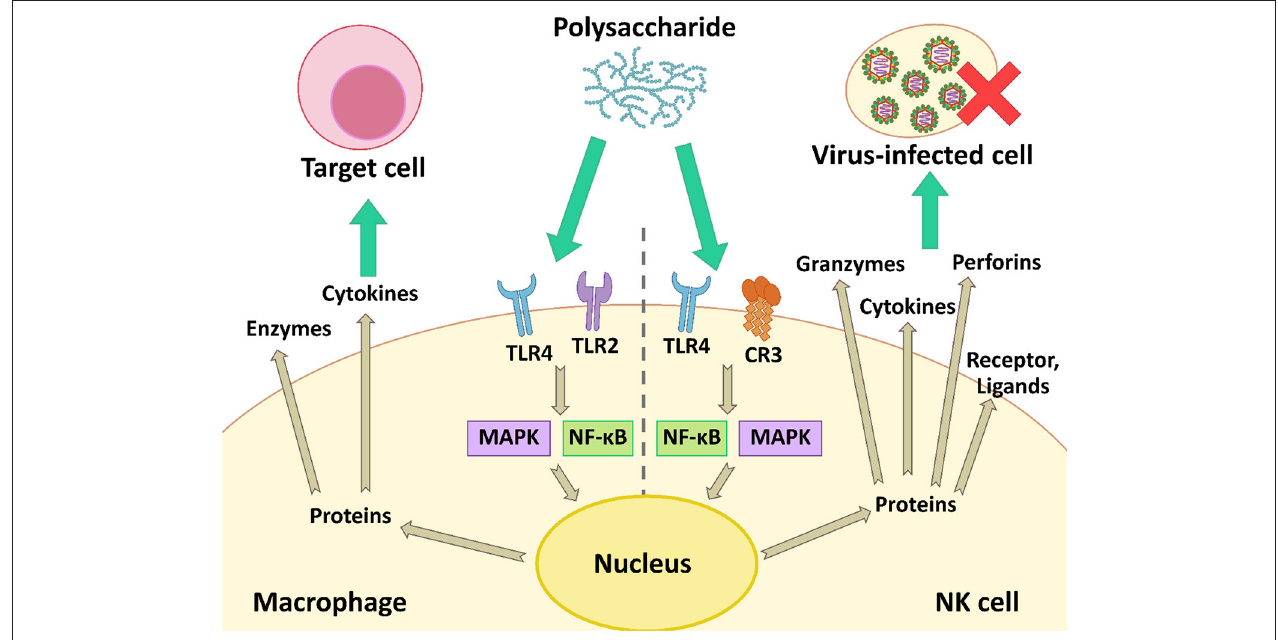
FIGURE 5 | The modulation of the antiviral immune response by activation of macrophage and NK cell using the NF- κ B and MAPK signaling